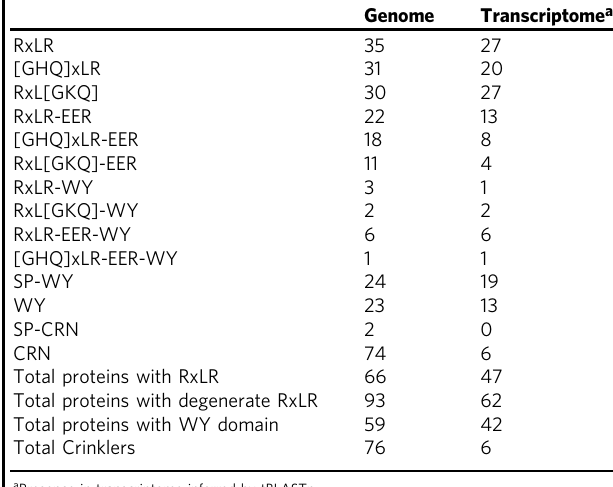
Table 2 Counts of annotated effectors in the B . lactucae genome and transcriptome